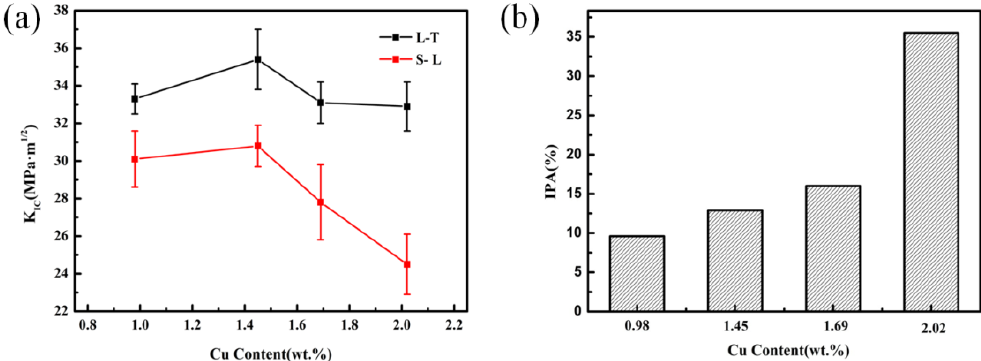
Figure 6. Fracture toughness and IPA of the alloys with different Cu contents: ( a ) Fracture toughness; ( b ) IPA. ( b )